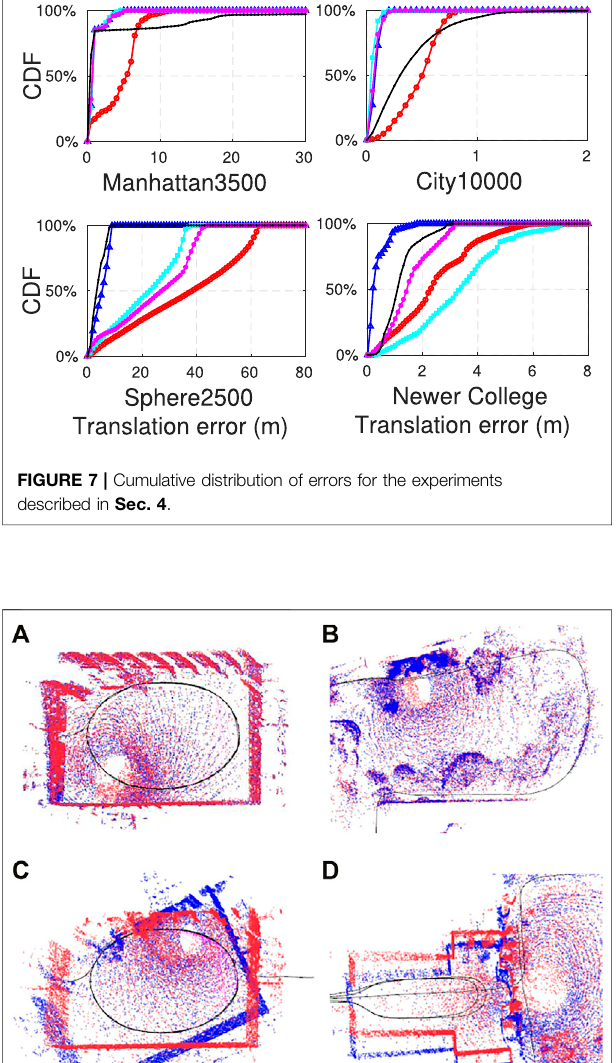
Frontiers in Robotics and AI |